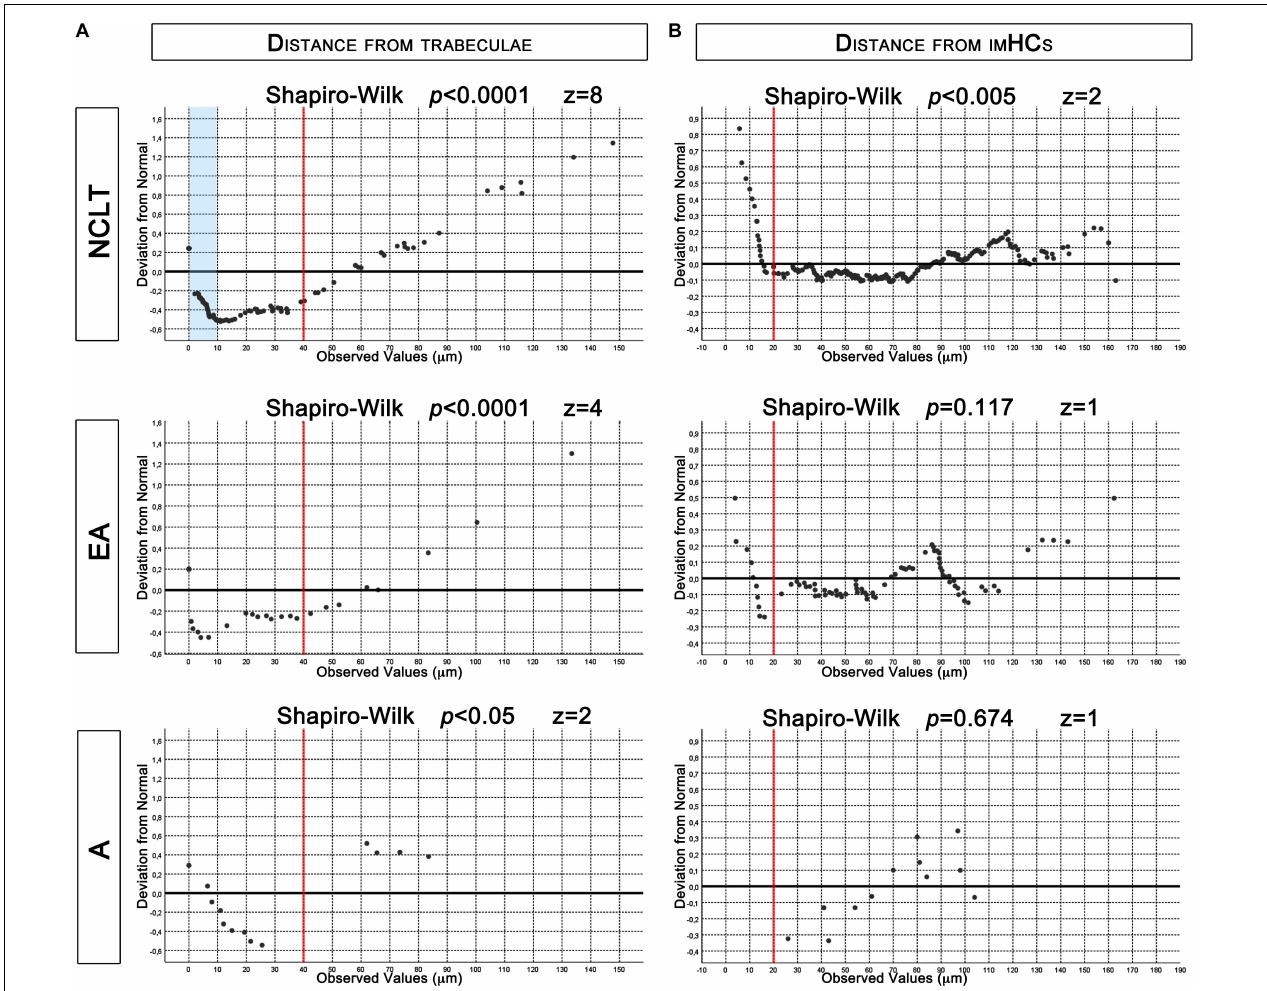
FIGURE 6 | De-trended Q-Q plots of data distribution. (A) Asymmetrical distribution of measured distances from trabecula, reported for NCLTs and EA, revealed increased frequency of data between 0 and 40 µ m (red lines). In this region data distribution of NCLT showed increased frequency of measures lower than 10 µ m (pale blue box). Conversely in EA and A the data were symmetrically dispersed. (B) Even if potentially symmetric, measured distances from imHCs in NCLT resulted not normally distributed due to increased frequencies below 20 µ m (red lines). Conversely, in EA and A the distribution resulted